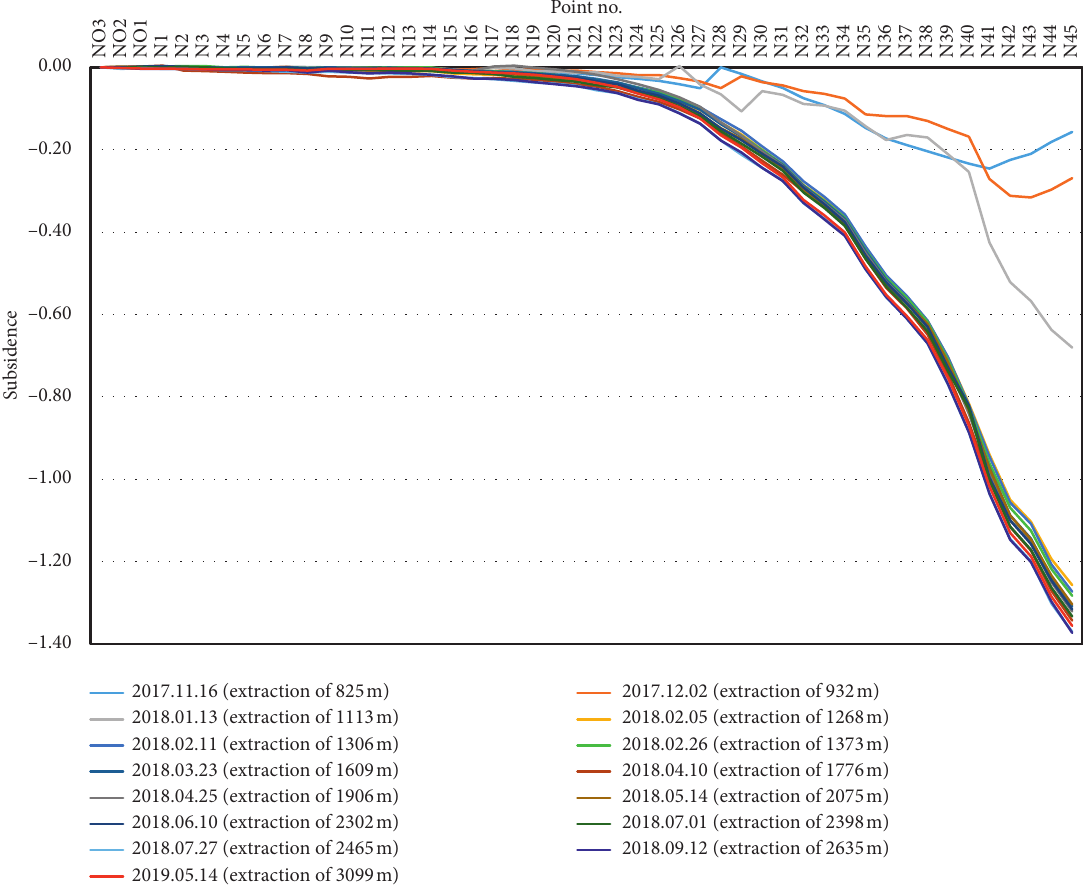
Figure 6: Profile of monitoring Line N along strike of 31102 panel. Table 3: Monitoring times for Line Q and the corresponding face advance